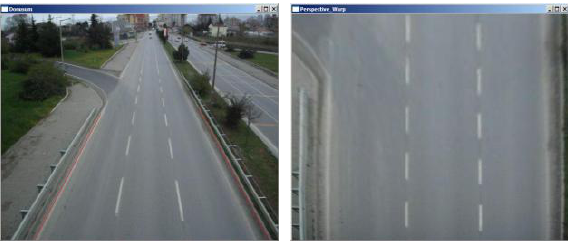
Figure 1. The original (left) and the rectified (right)